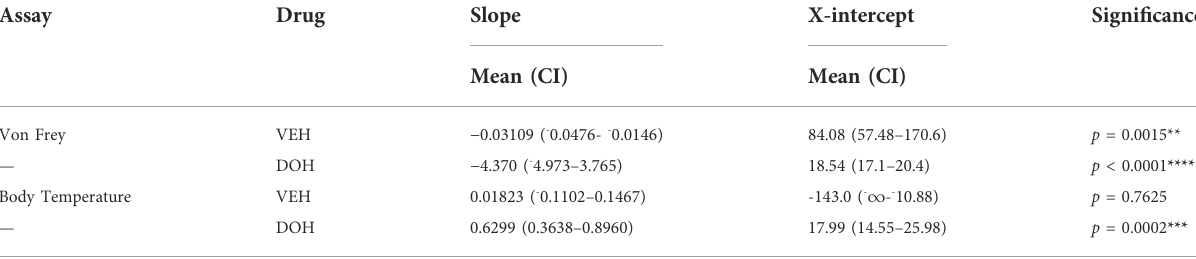
TABLE 4 Calculated slopes (mean +95% con fi dence intervals) and x-intercepts for the anti-allodynic and hypothermic effects of vehicle (VEH)- and decursinol (DOH)-treated groups across day in neuropathic mice. Linear regression analyses were used to determine the slopes from the daily tolerance curves following once-daily treatment with either vehicle (VEH) or decursinol (DOH) across 14 days of once-daily treatment in mice with neuropathicpain.Theslopeswereextrapolatedtodeterminethe x -interceptindicativeofwhentheresponsefollowingtreatmentwouldbe0.Values shown are the slopes and extrapolated x-intercepts and 95% con fi dence intervals for vehicle and decursinol treated mice (N = 12/group). ∞ = values that could not be calculated/were listed as in fi nity. Signi fi cance denotes a signi fi cant difference in the slope from 0.